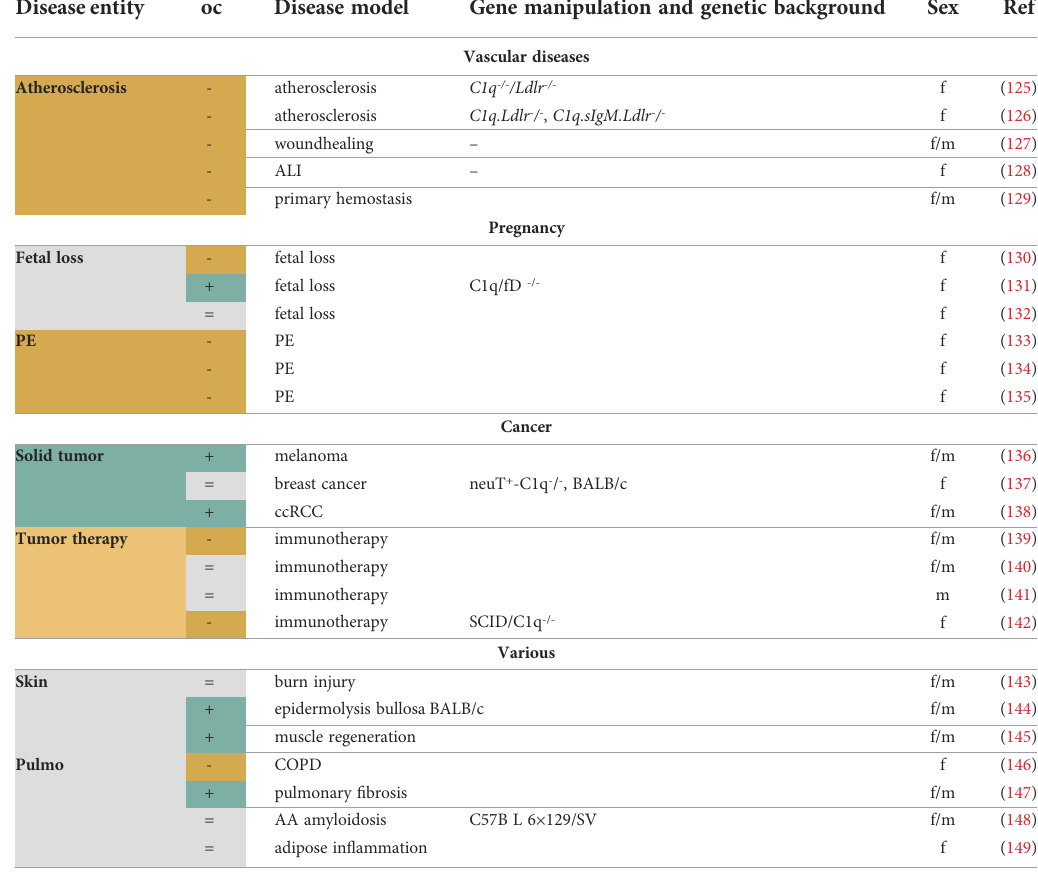
TABLE 3 Overview of publications in the disease clusters Vascular diseases, Pregnancy, Cancer and Various. Disease